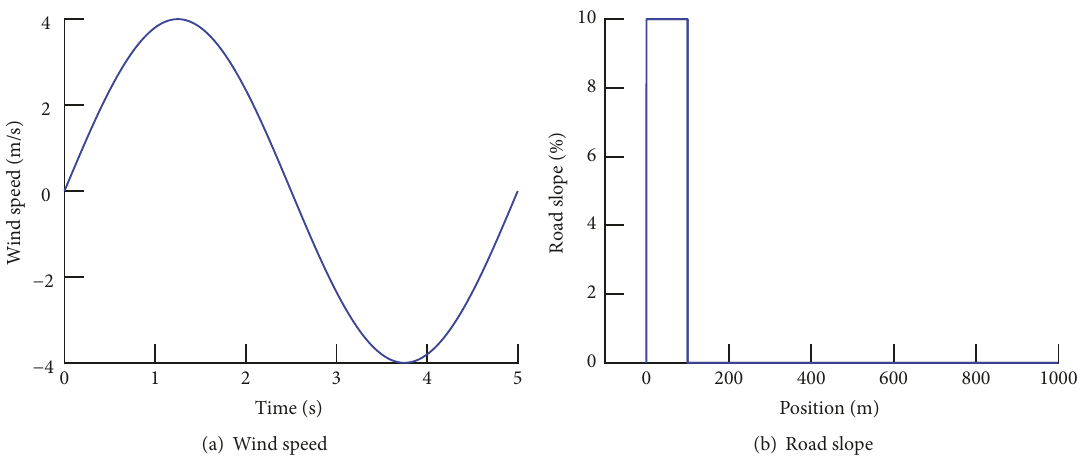
Figure 9: One period of external